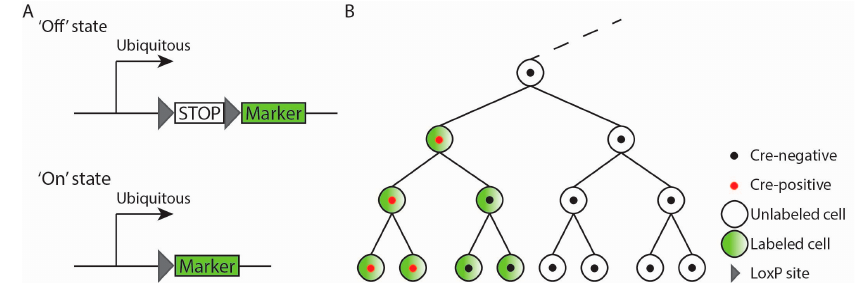
Figure 2. Genetic fate mapping relies on recombinase-mediated excision to switch ‘On’ and label cells and their progeny. ( A ) The ubiquitously active reporter transgene consists of a STOP-gene flanked by two LoxP sites (‘floxed’ STOP-gene) and a gene encoding a marker. Cre recombinase recognizes the two LoxP sites and excises the STOP cassette. The reporter is in the ‘Off’ state, but after Cre-mediated excision switches to the ‘On’ state, expressing the marker and thereby labels the cell; ( B ) Schematic representation of genetic fate mapping. Only cells that express Cre during development will switch the reporter transgene to the ‘On’ state. As this is a heritable recombination event, all the descendants of these cells will be labeled likewise, independent of Cre expression, and can be characterized.